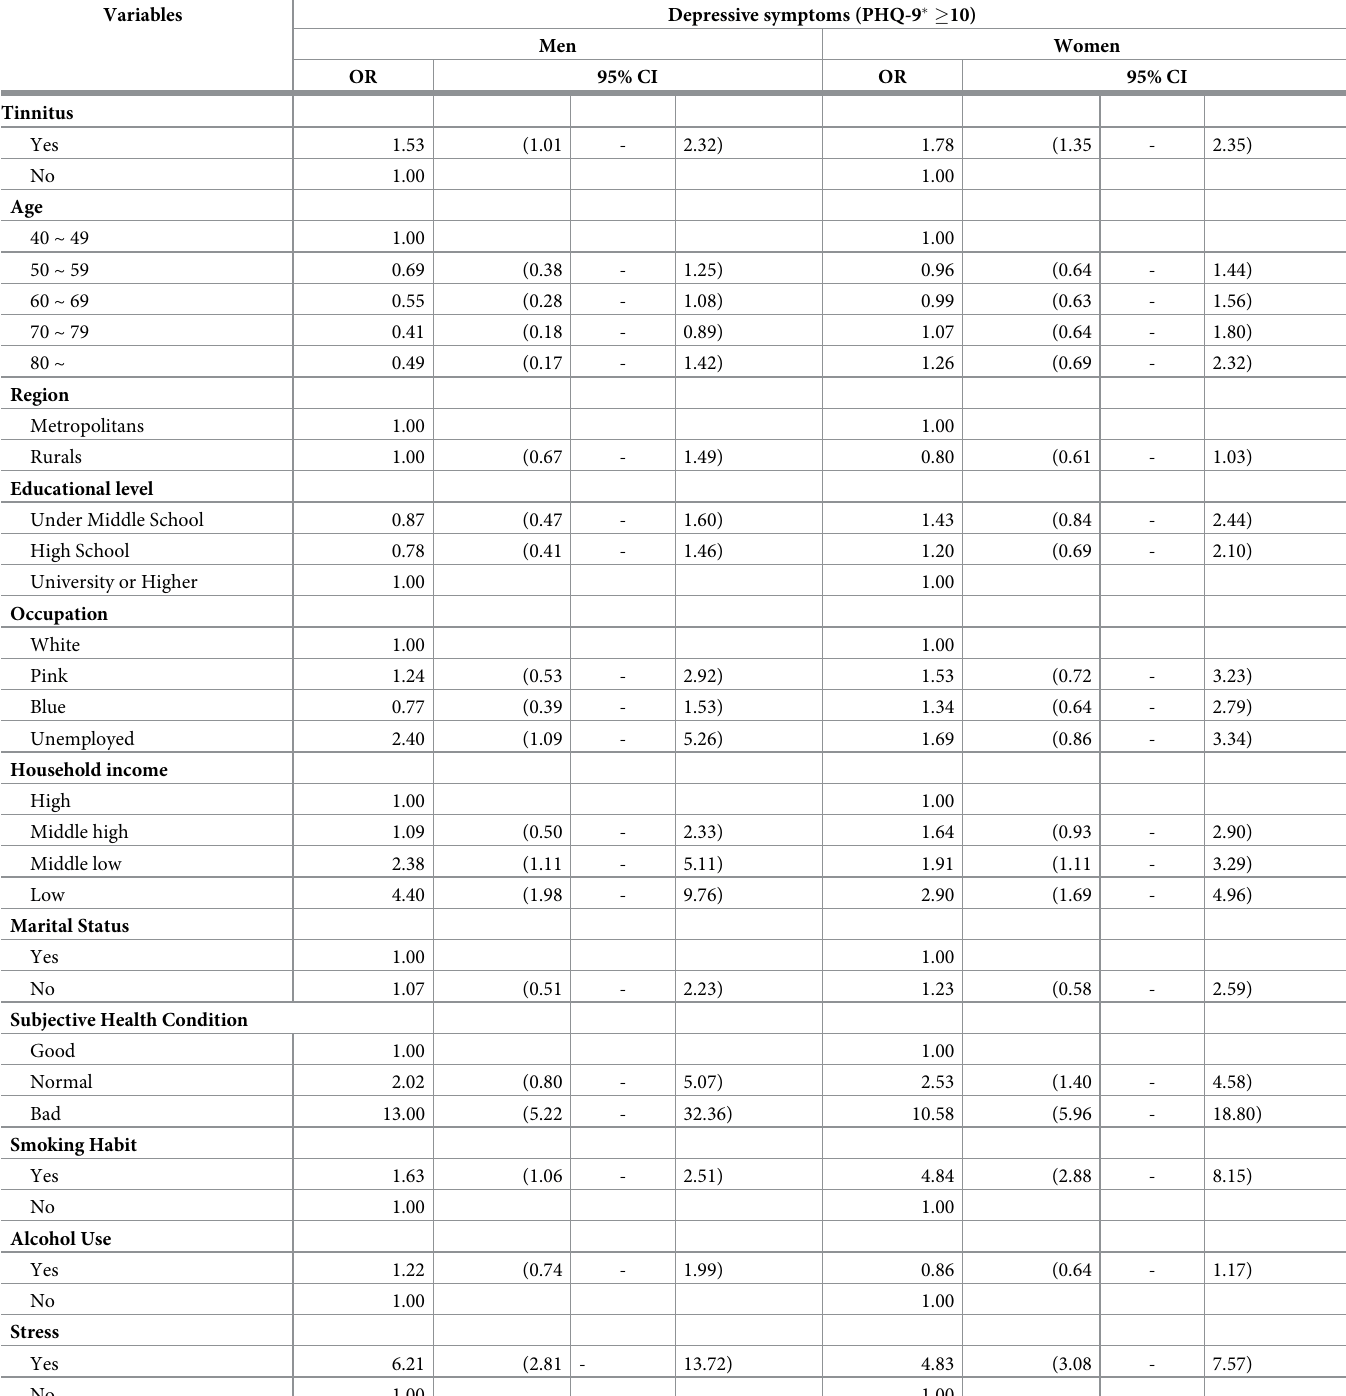
Table 3. Associations between depressive symptoms (PHQ-9) and subject demographics.